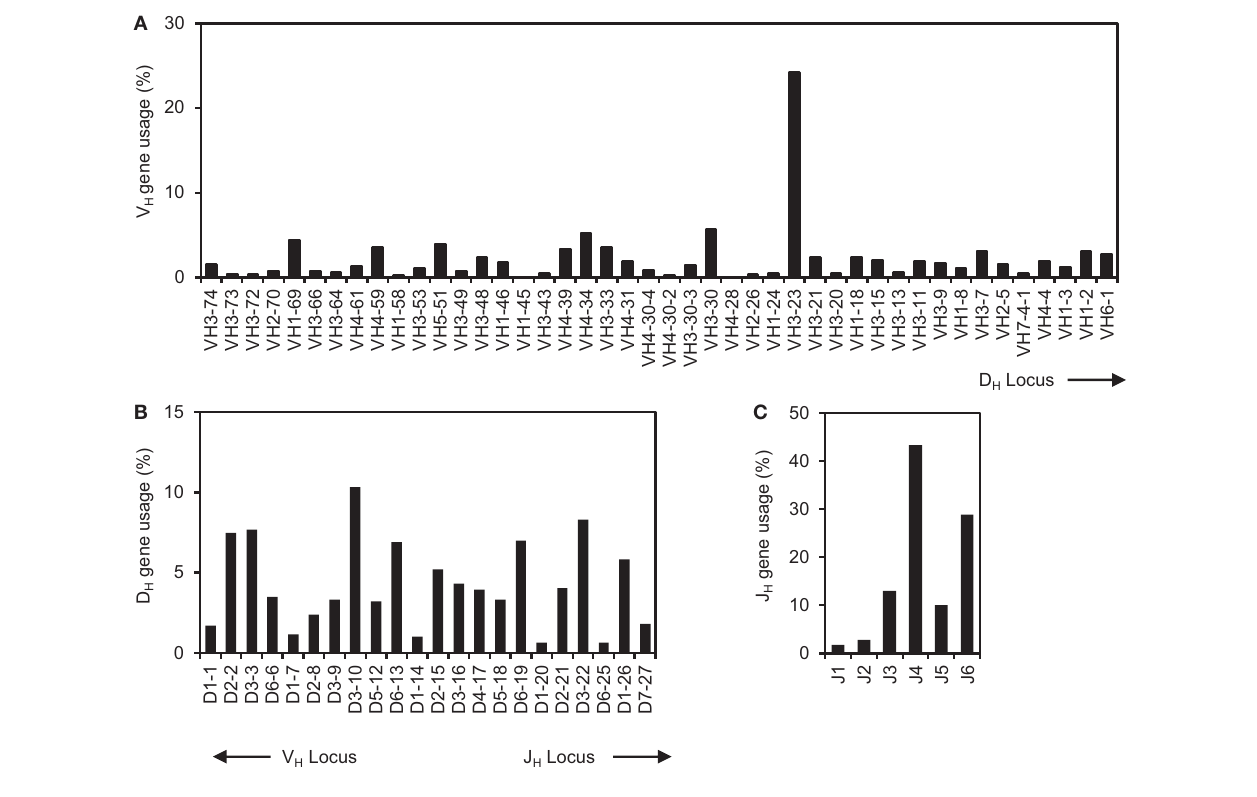
usage using the IMGT/V-Quest program and the identical sequences were removed.The frequencies ofV H (A) , D H (B) , and J H (C) germline gene usages in the 39,438 unique human IgH gene sequences were